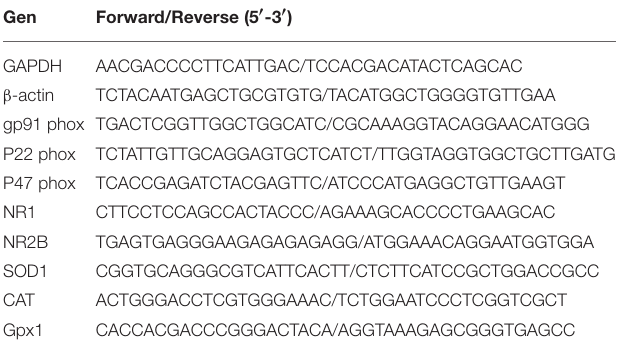
TABLE 1 | Primer used for qPCR. Gen Forward/Reverse (5 ′ -3 ′